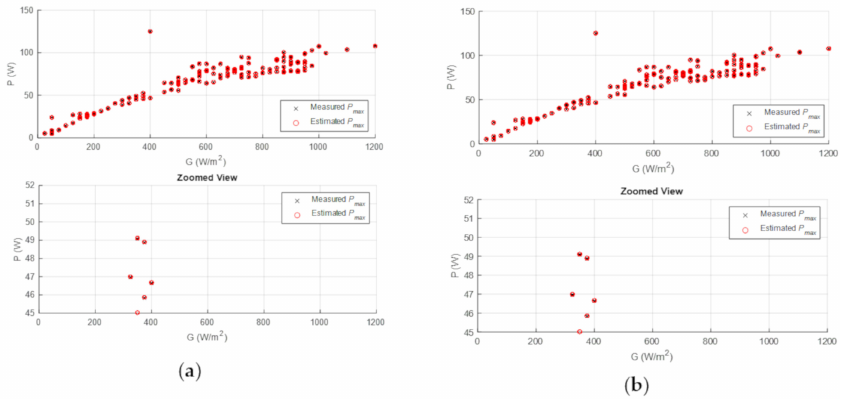
Figure 10. Predicted and measured P max for di ff erent temperature values using: ( a ) SVR; ( b ) GRNN.